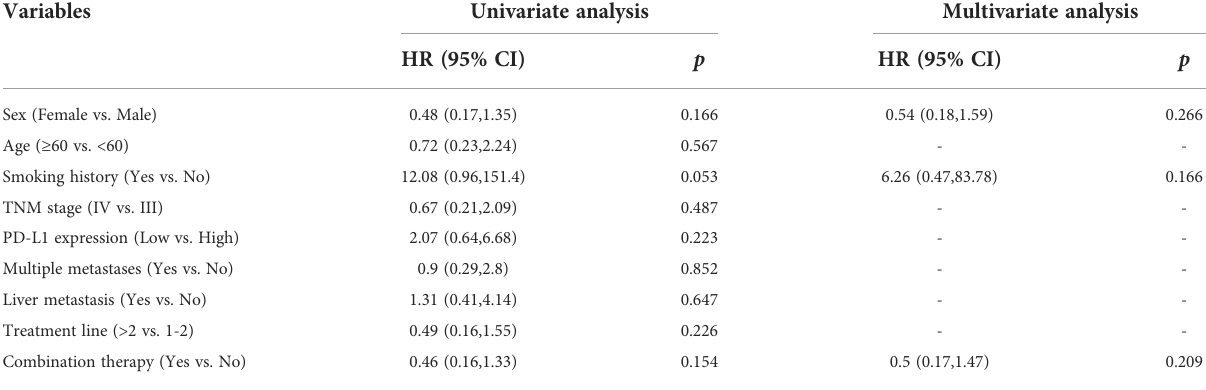
TABLE 3 Univariate and multivariate analyses of factors for progression-free survival in the combined two cohorts. Variables Univariate analysis Multivariate